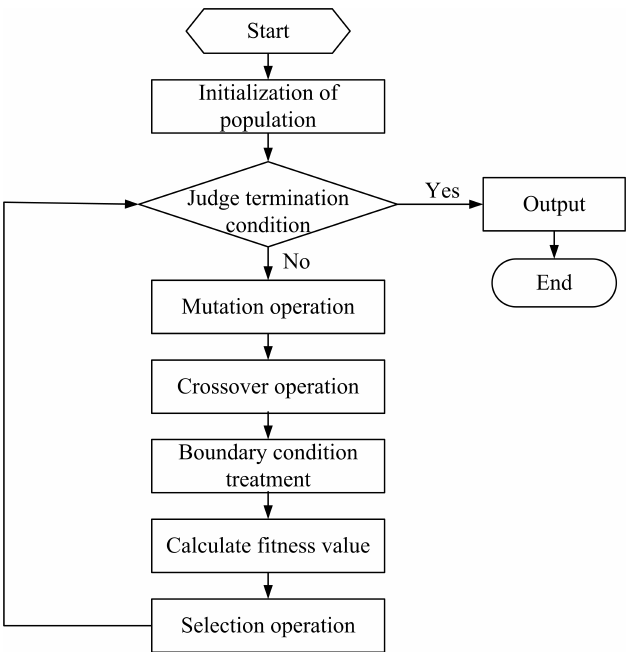
Figure 4. Operation flow of Differential